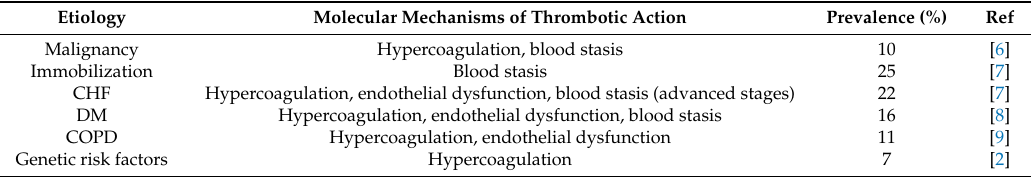
Table 1. Most frequent causes of venous thromboembolism (VTE) in the elderly.